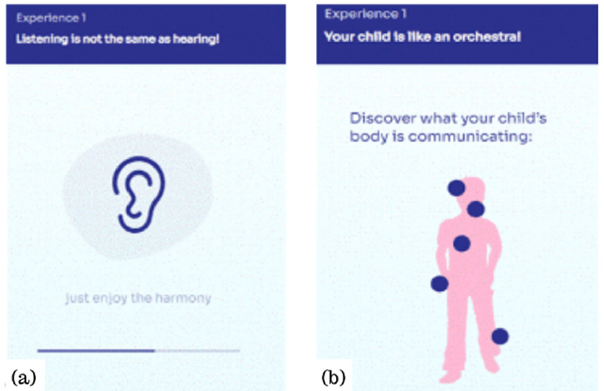
Figure 4. Two examples of interactive activities within the section “Things to know” for the Experience “Listening with full attention”. The first activity ( a ) is “Listening is not the same as hearing”. The second activity ( b ) is “Your Child is like an orchestra!”.